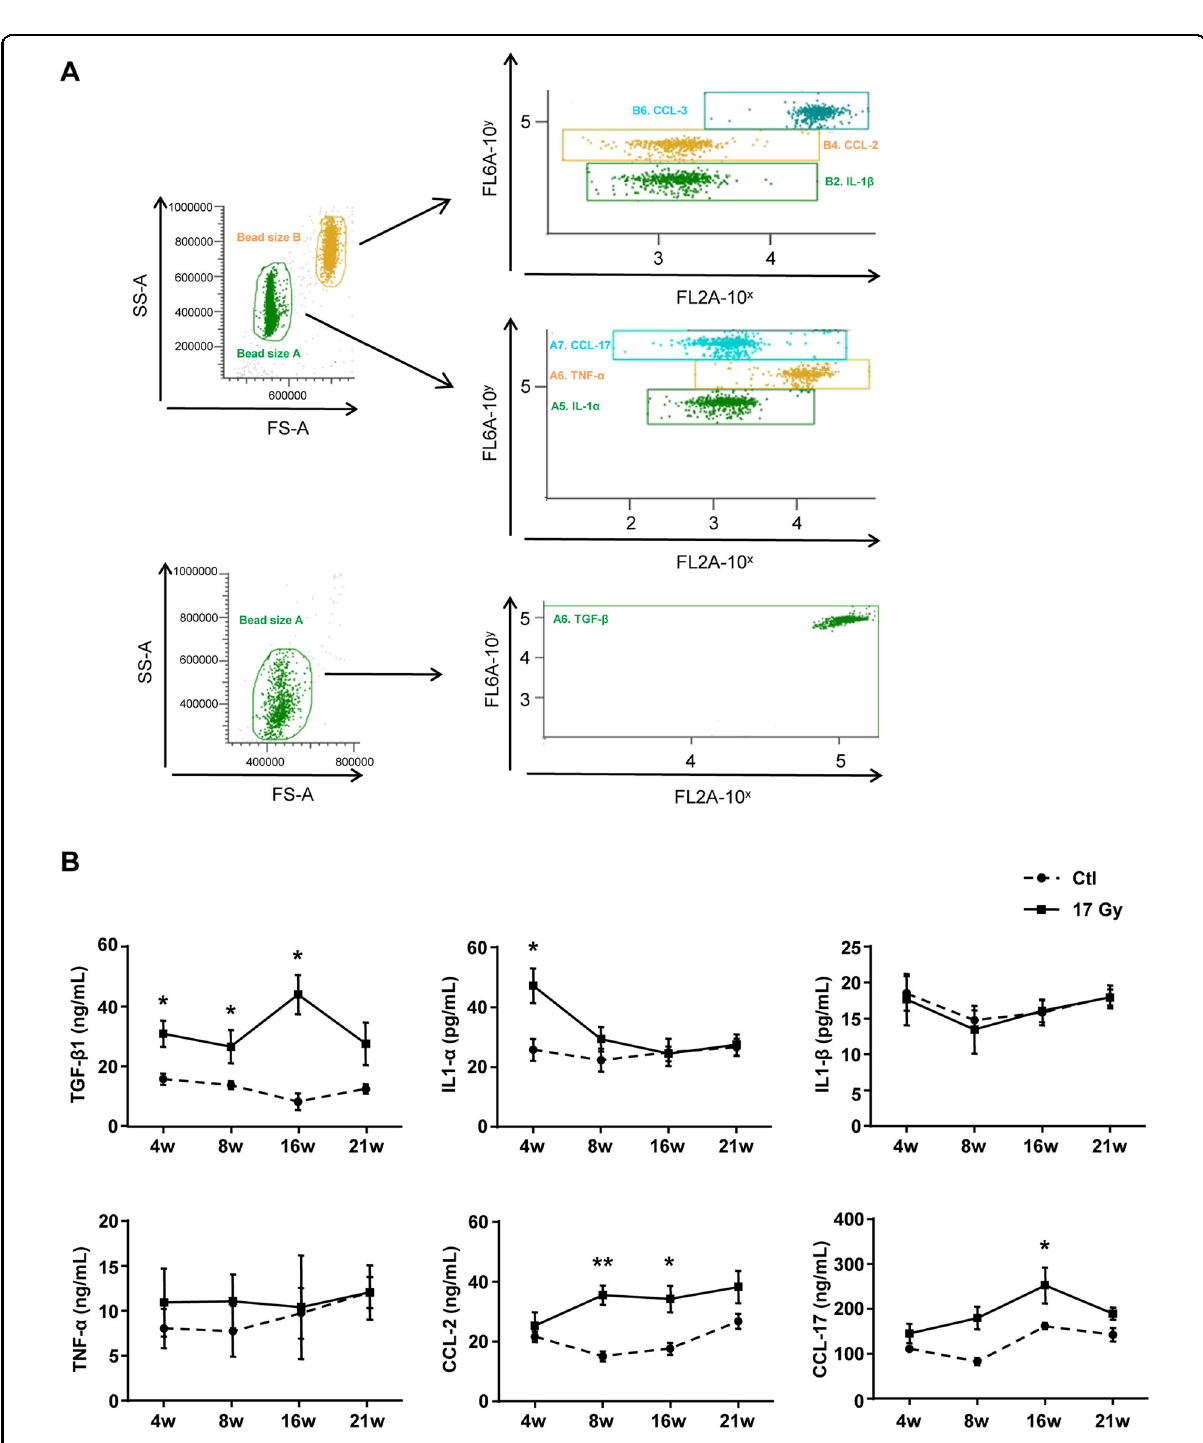
Fig. 5 Thoracic IR induced augment of SASP components in lung tissues. C57BL/6J mice were exposed to a single dose of 17 Gy IR on the right side of the thorax. Samples of right lung tissue were collected at intervals after IR and in controls. The lung homogenates were measured by cytometric bead array (CBA) Kit and FCM. A Representative images of CBA staining. B The protein levels of SASP components, including TGF- β 1, Il-1 α , Il-1 β , TNF- α , CCL2, and CCL17 in homogenates of right lung tissue. Data are expressed as mean ± SEM of six independent experiments, ** P < 0.01 and * P < 0.05 compared with the corresponding